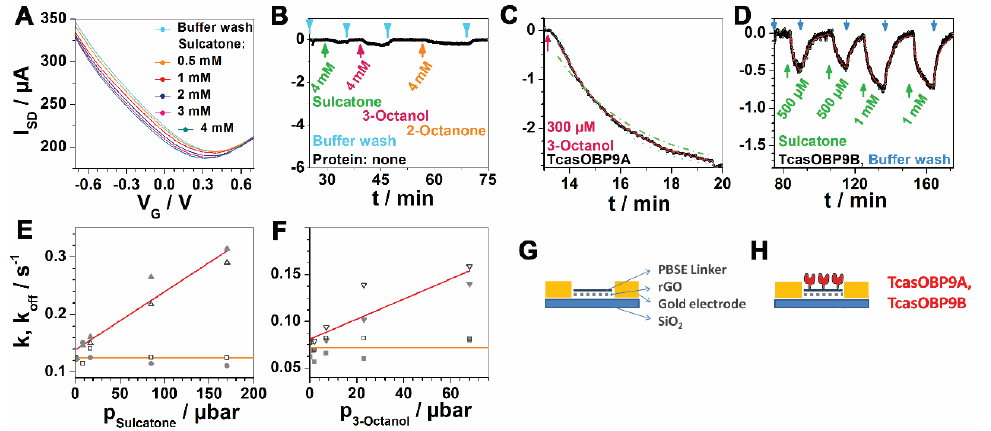
Figure 2. Controls, EAGs, and setup. ( A ) I D -V G curves of sulcatone, as used to determine the V G measuring range. ( B ) Negative control of the plain FET (without protein), as shown in panel S. ( C ) Close-up of one titration step, showing the fit (red line) in a k ± 20% simulated error range, as described previously [14] (dotted and dashed-dotted lines). ( D ) Quantitative repeatability. The first and second, as well as the third and fourth, injections had the same odorant concentration and led to the same stimulus of the synthetic receptor. ( E , F ) Electroantennogram (EAG) data are shown as k/p-plots (red lines) and are reproduced courtesy of the authors of [25]. Orange lines show the non-concentration-dependent off-rates obtained from these EAGs. ( G , H ) Sketches of the setup.